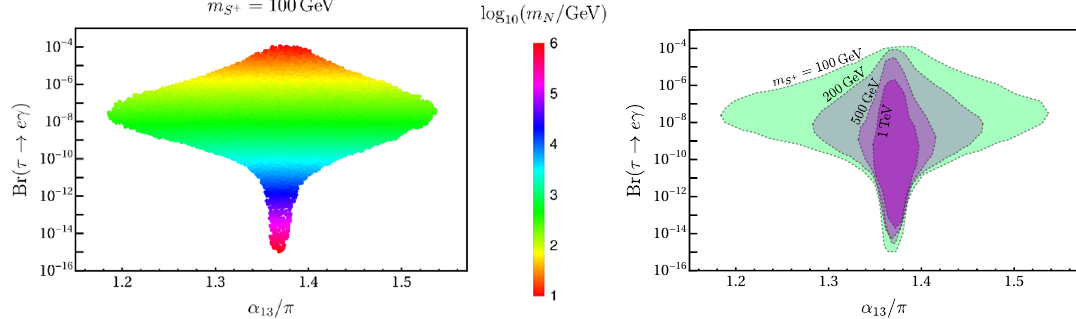
Figure 17 . Br( (cid:28) e(cid:13) ) for di(cid:11)erent values of m N and m ! how by modifying m N the parameter space widens or narrows due to perturbativity arguments. A similar behavior can be observed for the plot on the right, where we show contour lines for di(cid:11)erent values of m scanning over m N S +